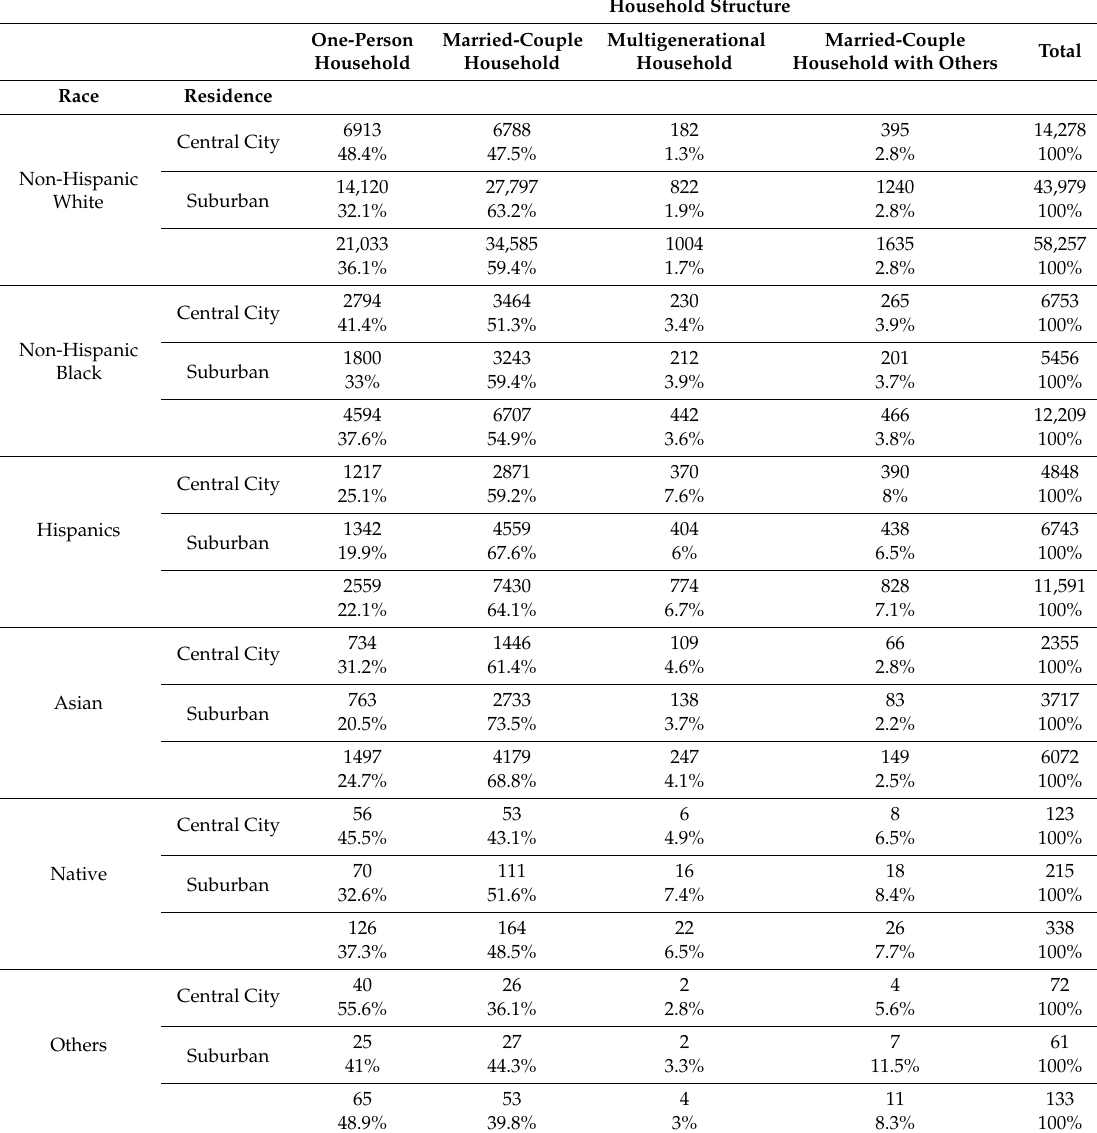
Table 2. Residential Status of Household Structure by Race in U.S. Metropolitan Area. Household